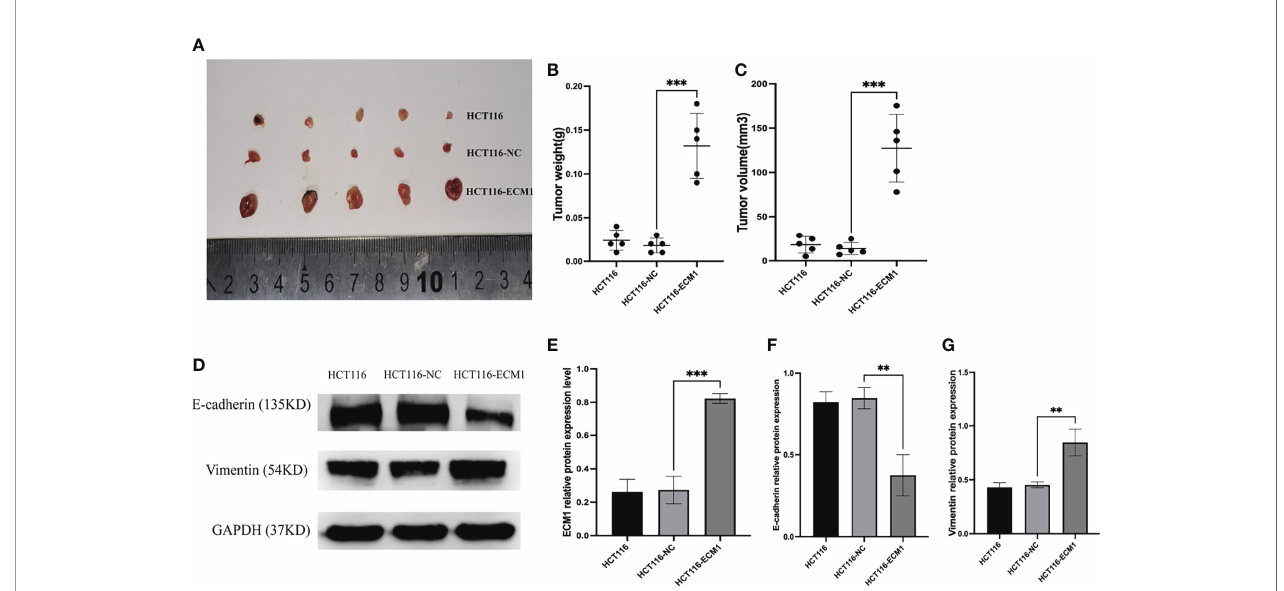
FIGURE 8 | ECM1 promotes in vivo CRC tumor growth. (A – C) ECM1 enhanced in vivo tumor growth, as determined through measurements of tumor weight and volume at 25 days post-implantation. (D – G) ECM1, Vimentin, and E-cadherin expression levels in xenograft tumors were assessed via Western blotting. Data are means ± SD (**P < 0.01, ***P <